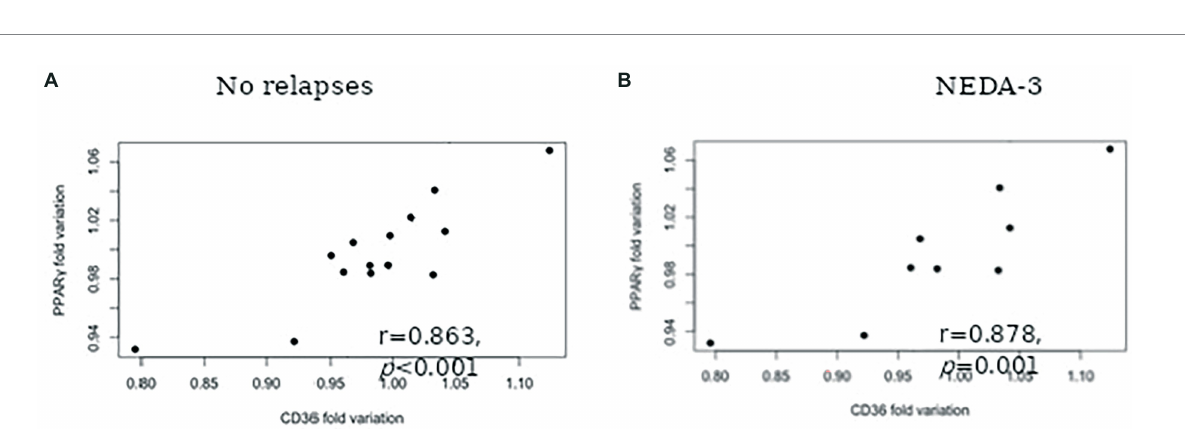
FIGURE 2 Spearman correlation between PPAR γ fold variation and CD36 fold variation for patients with: No relapses during the 12-months follow-up (A) and No evidence of disease activity (NEDA-3) (B)